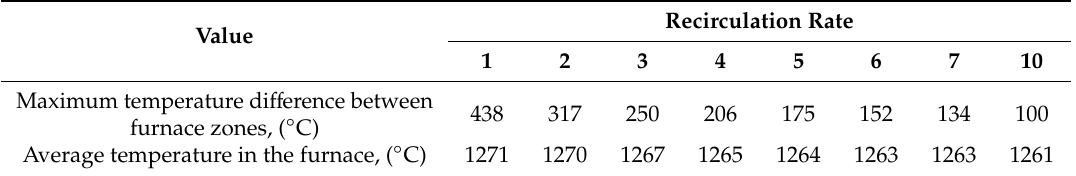
Table 3. Results of the calculation of volume combustion with different recirculation rates.